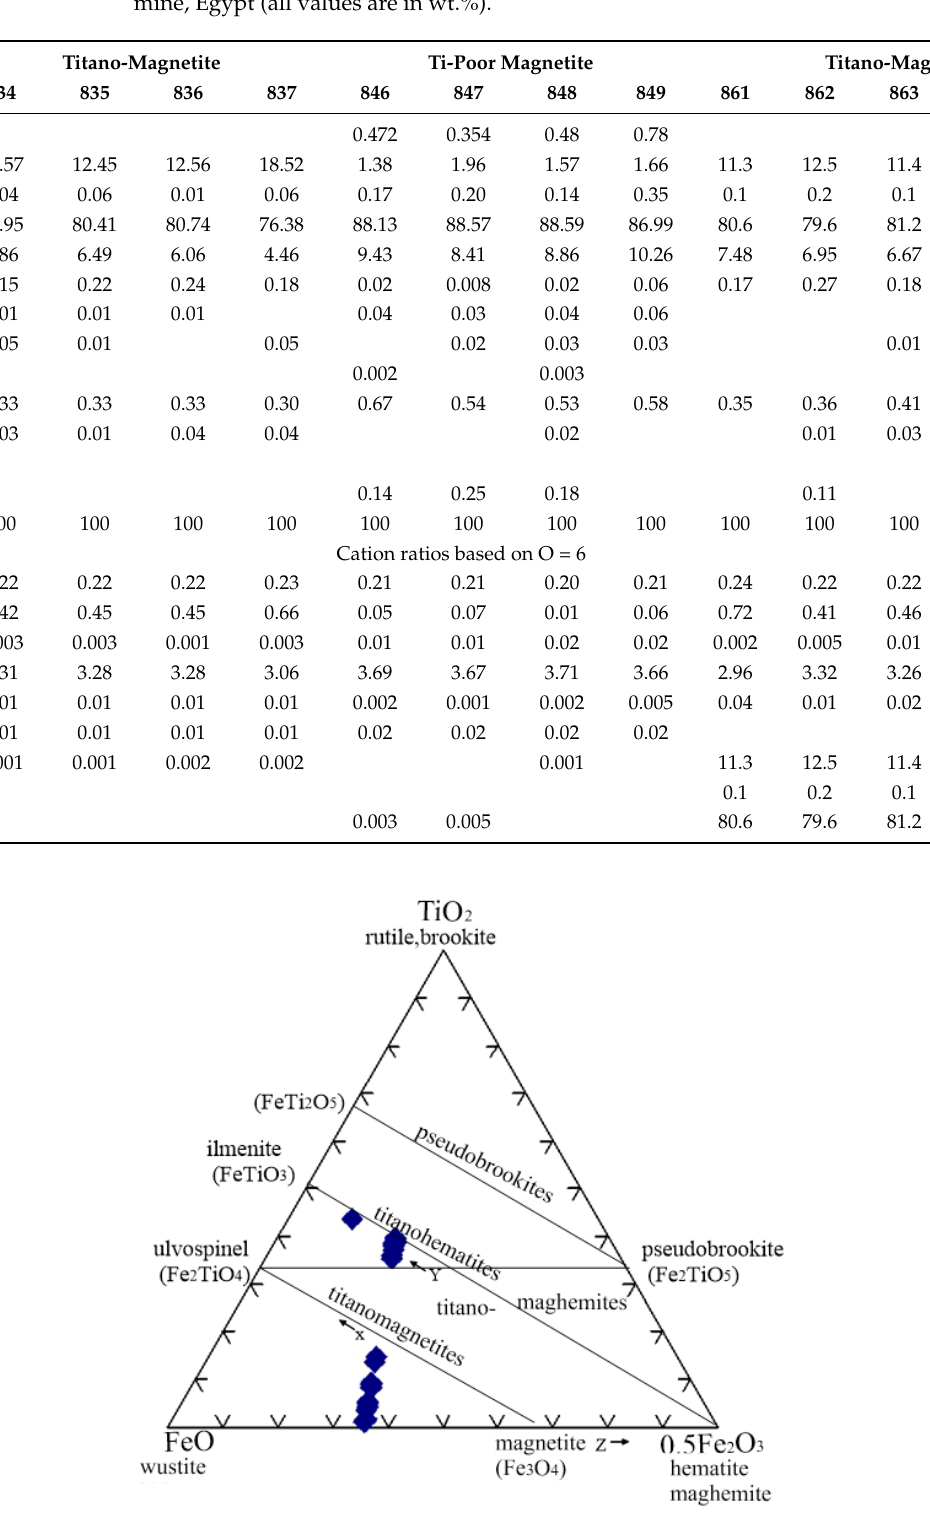
Figure 10. Ternary system of TiO 2 -FeO-1/2Fe 2 O 3 [30] showing the titano-magnetite and titano-hematite–hemoilmenite solid-solution lines and the titano-maghemite composition.